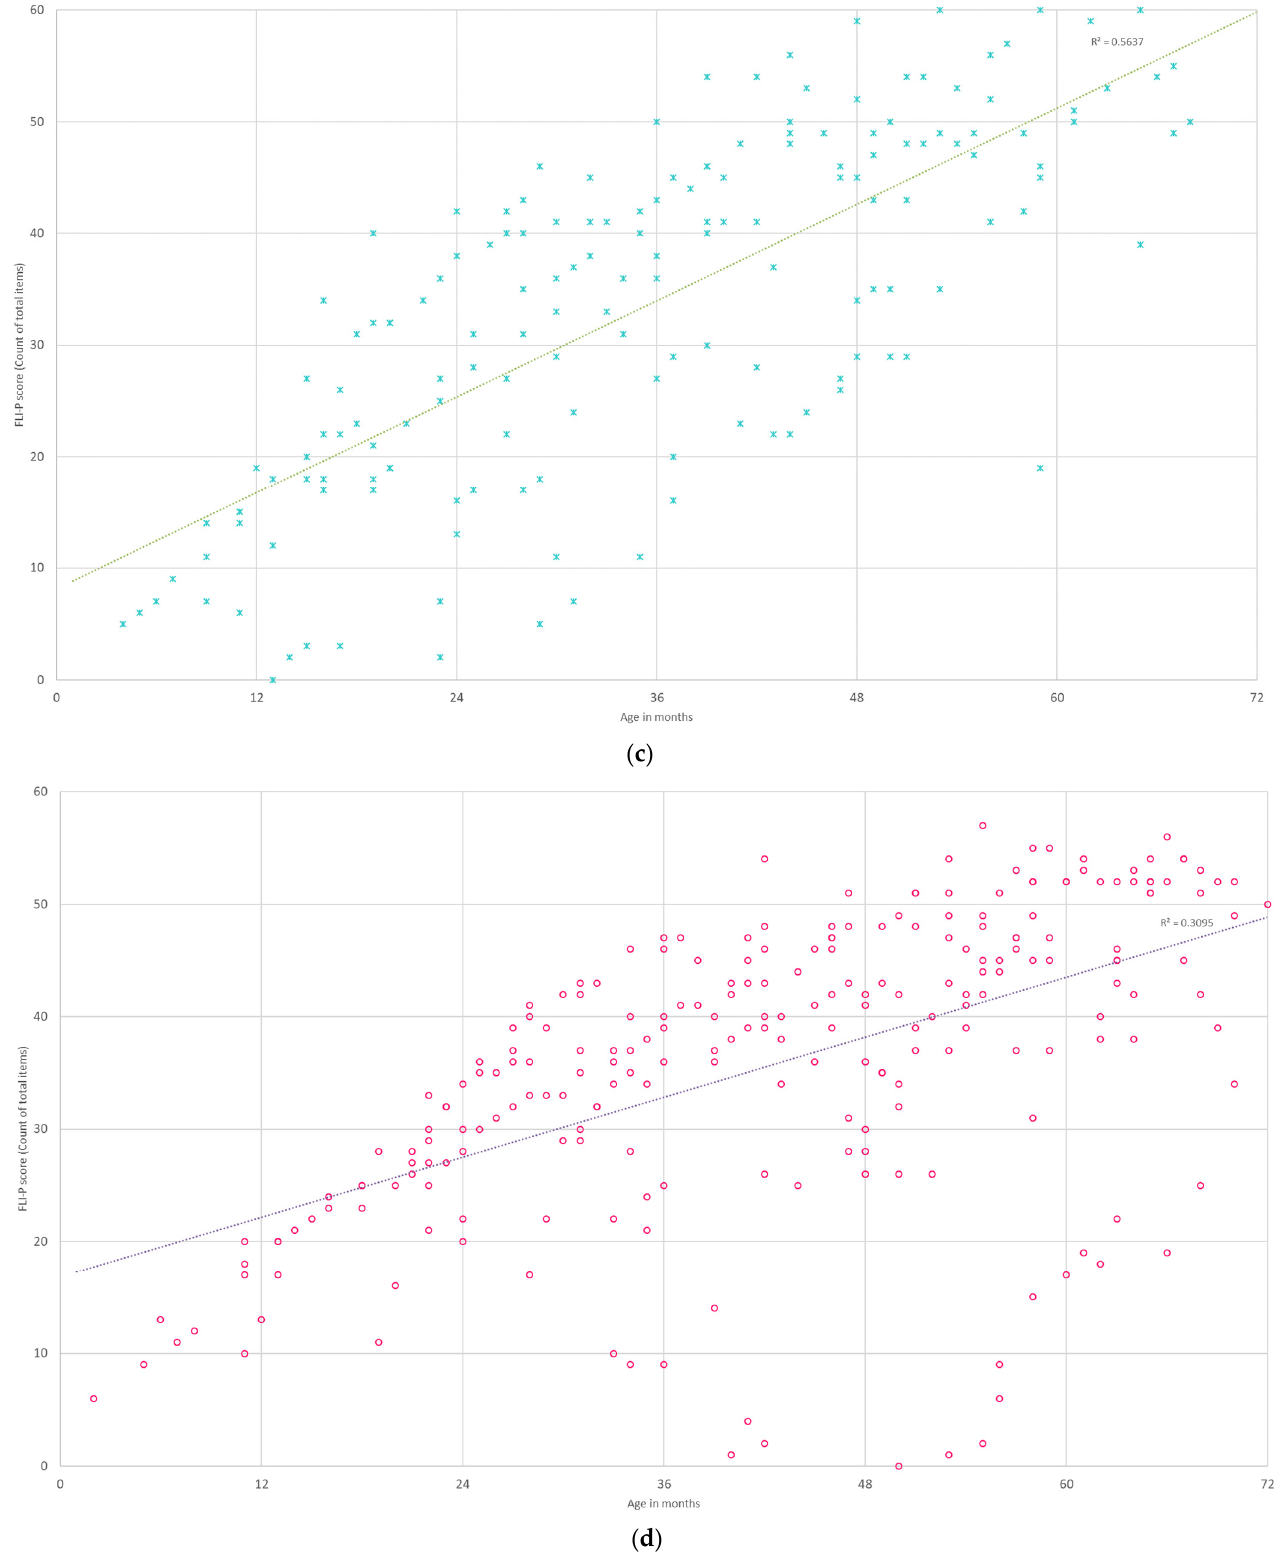
Figure 13. FLI-P scores for children with bilateral profound hearing loss by age at implant ( a ) <6 months; ( b ) 6–11 months; ( c ) 12–23 months; and ( d ) >24 months. ( a ) <6 months; ( b ) 6–11 months; ( c ) 12–23 months; and ( d ) >24